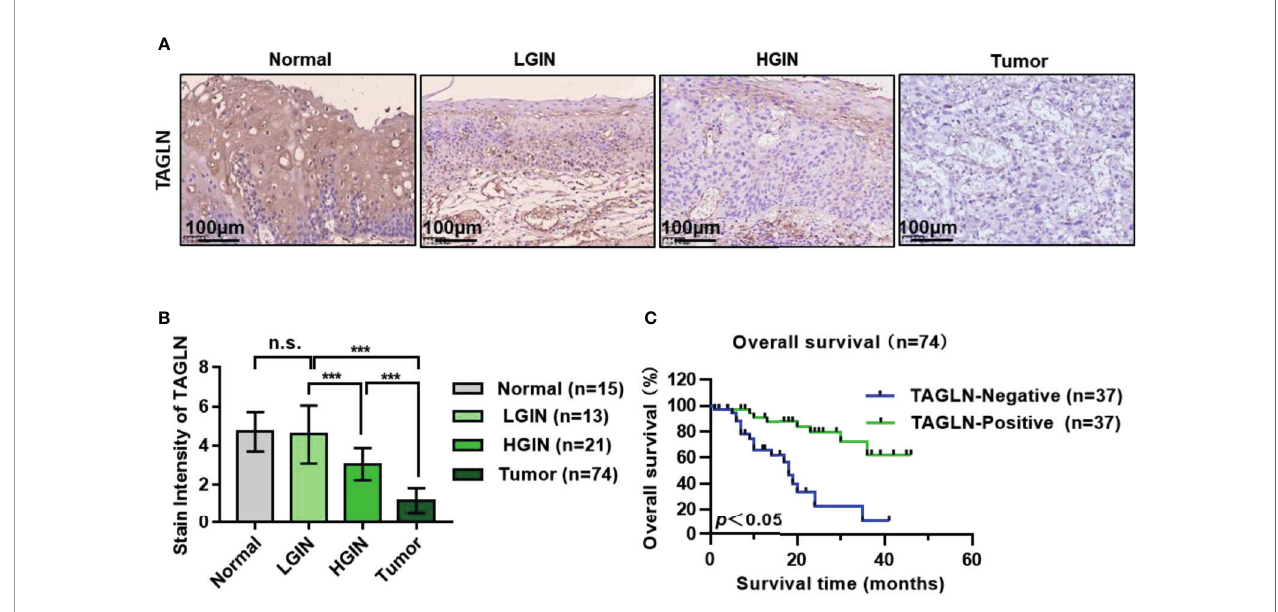
FIGURE 6 | Expression of Transgelin in esophageal squamous cell carcinomas and its relationship with prognosis of patients with esophageal squamous cell carcinomas. (A) The expression of Transgelin in Normal, LGIN, HGIN and Tumor tissues was detected by immunohistochemistry. (B) Statistical analysis of the expression of Transgelin in Normal, LGIN, HGIN and tumor tissues. The data are presented as the mean ± SEM. *** P < 0.001 by ANOVA analysis. (C) Survival analysis of Transgelin expression and prognosis in patients with esophageal squamous cell carcinomas. Kaplan-Meier method was used to calculate the relationship between Transgelin expression and survival prognosis of tumor patients. n.s., no signi fi